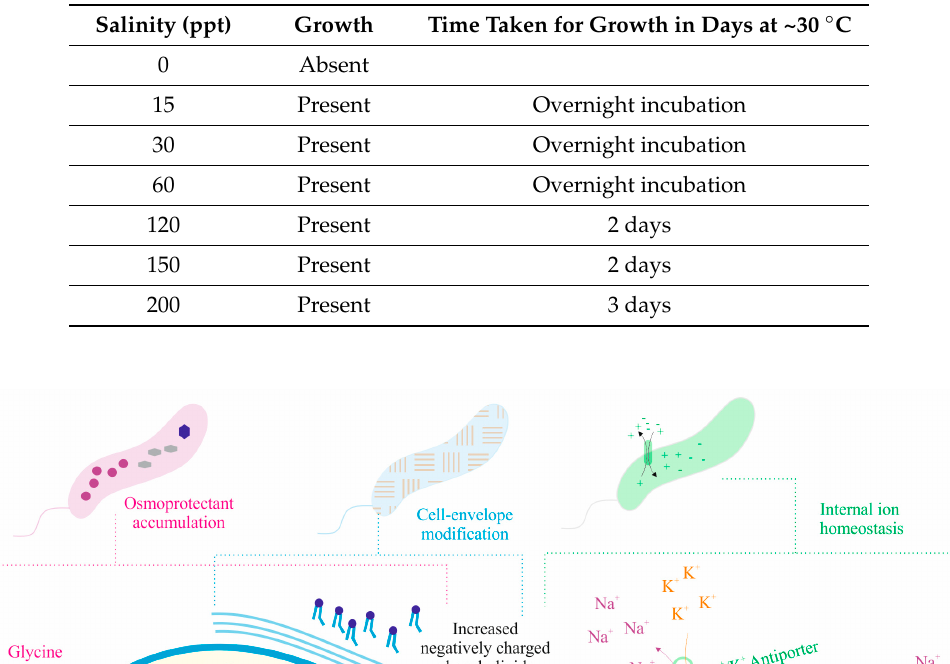
Table 2. Salinity tolerance of Salinivibrio sp. HTSP.